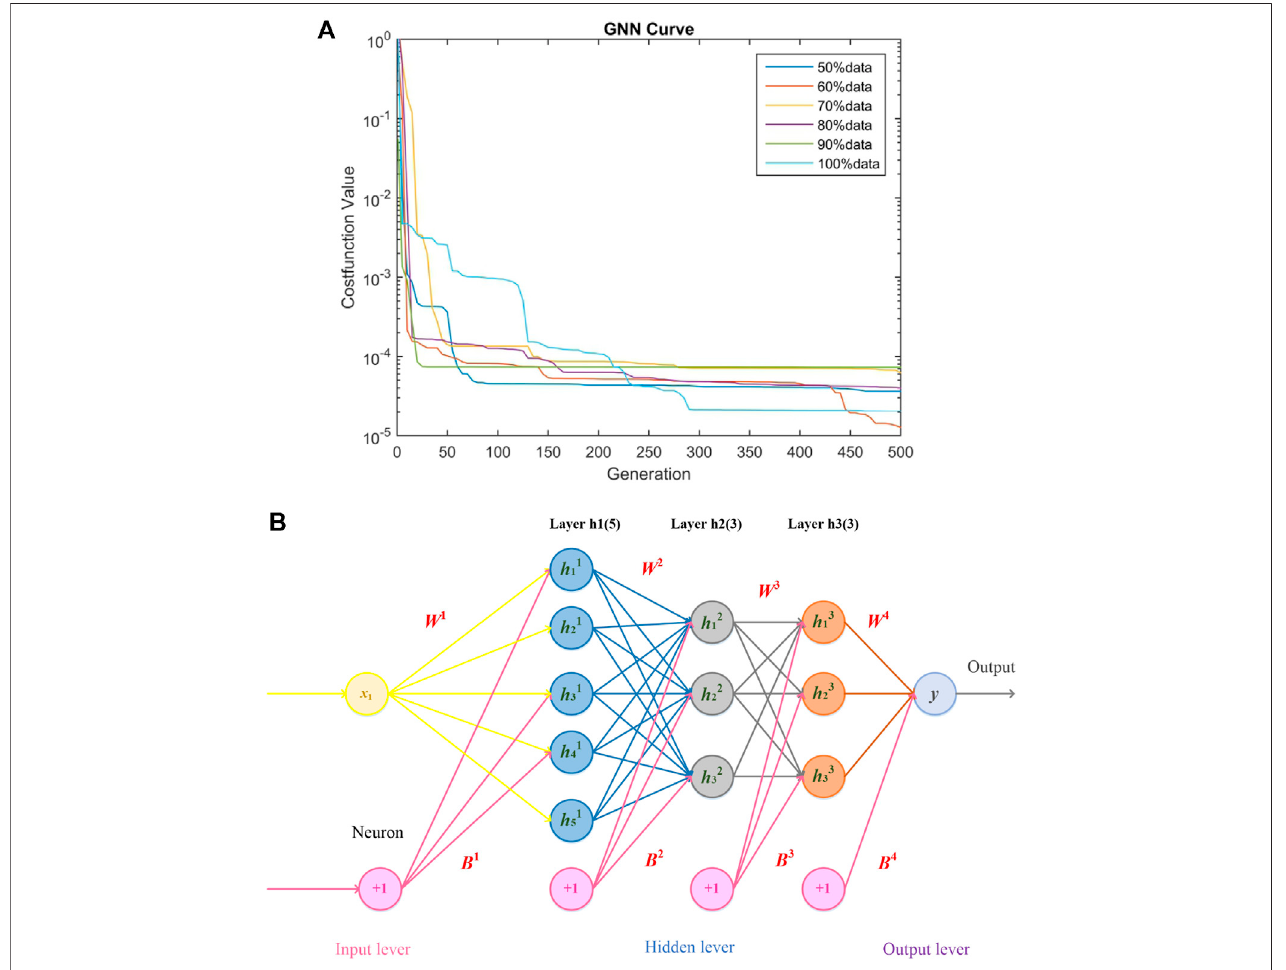
FIGURE 5 | Parameter setting of the GNN. (A) Convergence of cost function of the GNN under different training datasets; (B) framework design of the GNN.